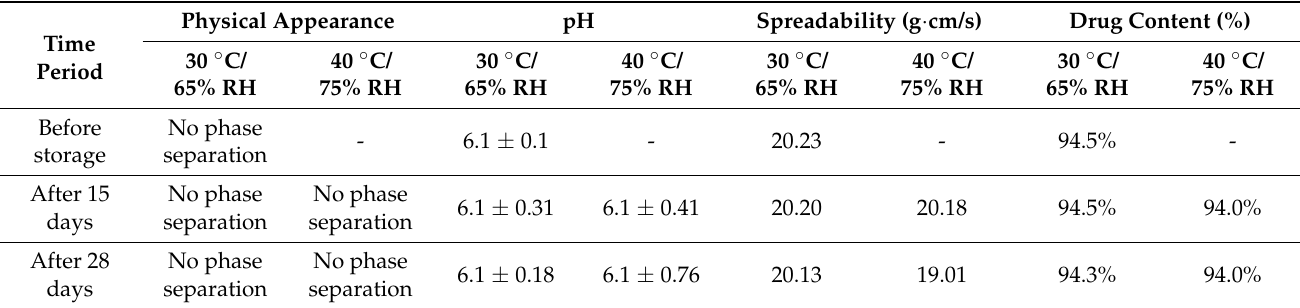
Table 7. Stability studies of optimized transemulgel formulation.